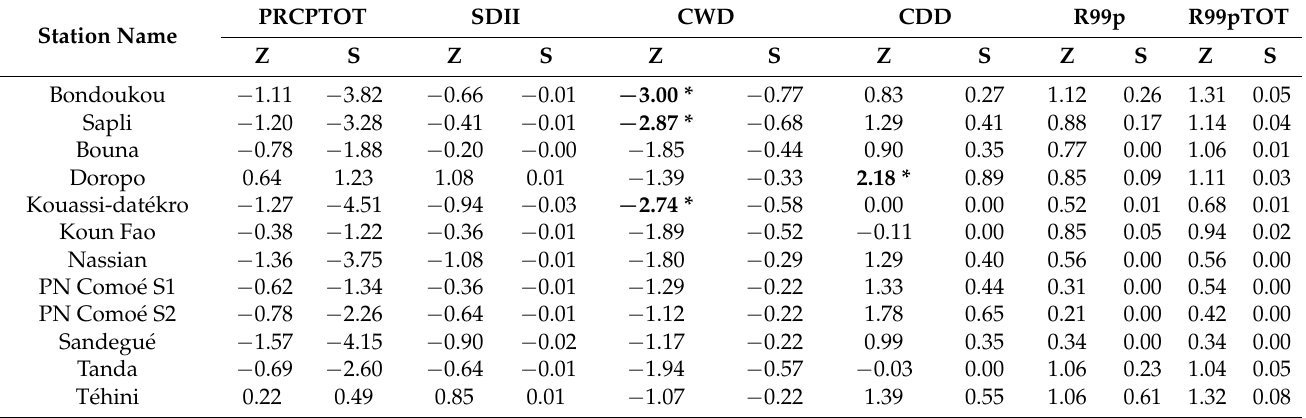
Table 4. Mann–Kendall (Z) trend test statistics and Sen’s slope (S) of extreme precipitation indices from 1981 to 2020 for the twelve stations.